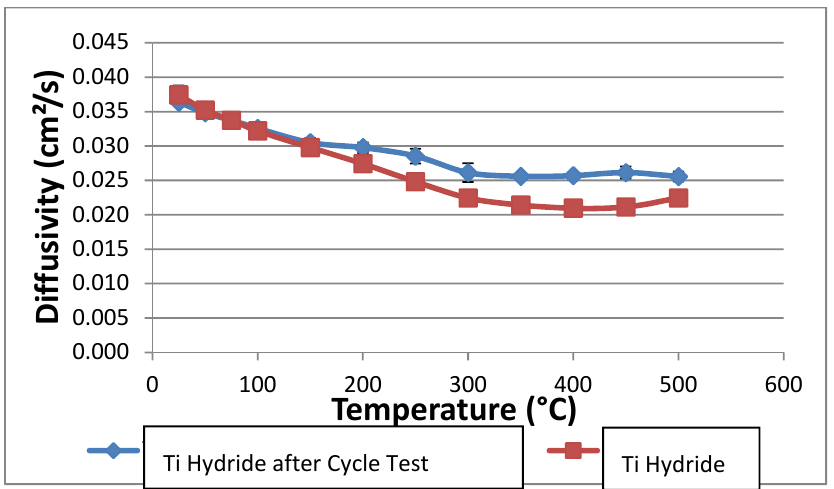
Figure 9. Thermal diffusivity of titanium hydride after multiple cycles compared to original titanium